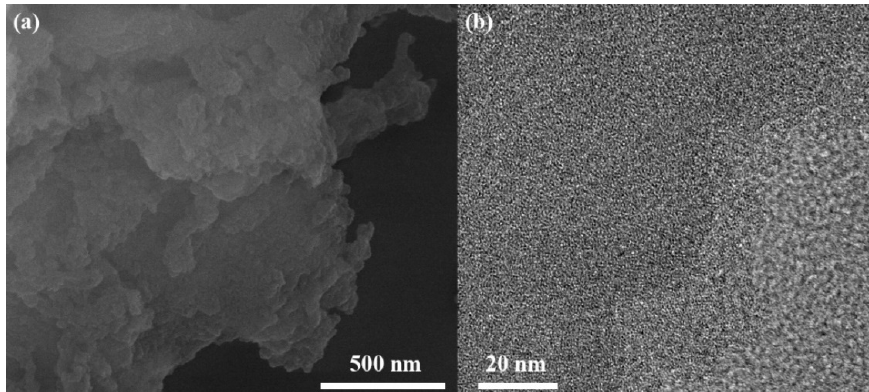
Figure 2. ( a ) SEM and ( b ) TEM images of the as-synthesized JJU-1.